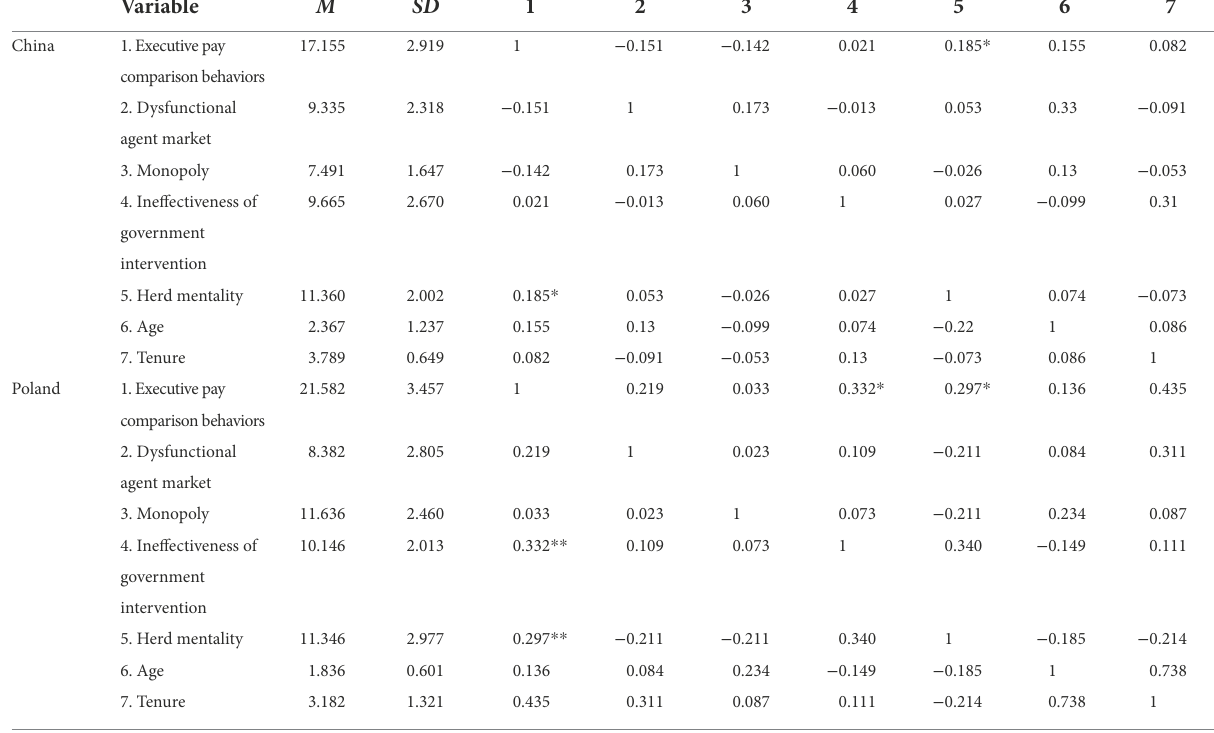
TABLE 2 Correlation analysis result between the relevant variables.